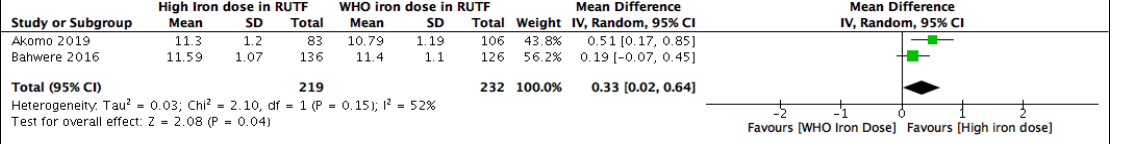
Figure 2. Effect of SMS-based RUTF with high iron content compared to that of peanut-based RUTF with WHO standard iron content on blood hemoglobin (g/dL). The forest plot shows pooled data from two studies for change in hemoglobin at the end of the study. Both the studies had data avail- able only for a subset of population. The published data from Akomo 2019 [4]. was adjusted for altitude and ethnicity; however, we had access to unadjusted data, and we pooled the same to be consistent with data from Bahwere ’s 2016 [12]. study that were not adjusted. The data from Bahwere 2016 was provided by authors and was not available from the published report. Akomo 2019 has two study groups. We included data from milk-free soybean, maize, and sorghum (FSMS) and a standard formulation prepared from peanuts and milk (PM-RUTF). Abbreviations: RUTF — ready- to-use therapeutic food; WHO — World Health Organization; SMS — soya – maize – sorghum.